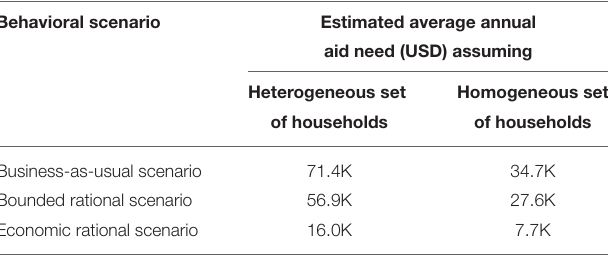
TABLE 3 | Average annual simulated cost of droughts (US$ per thousand